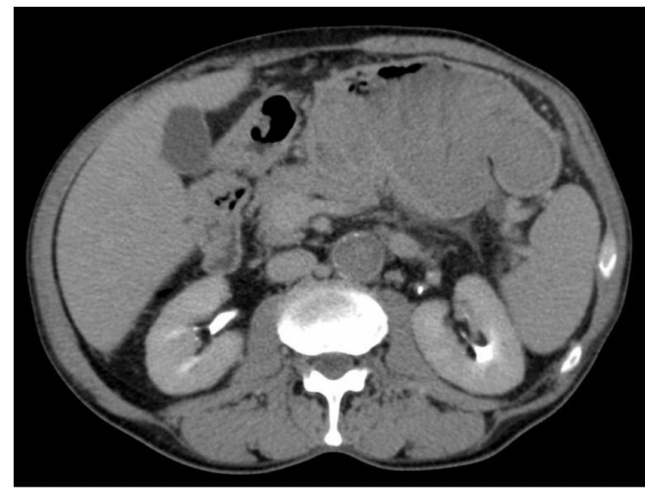
Figure 3. Gastric lesion in the delayed phase.